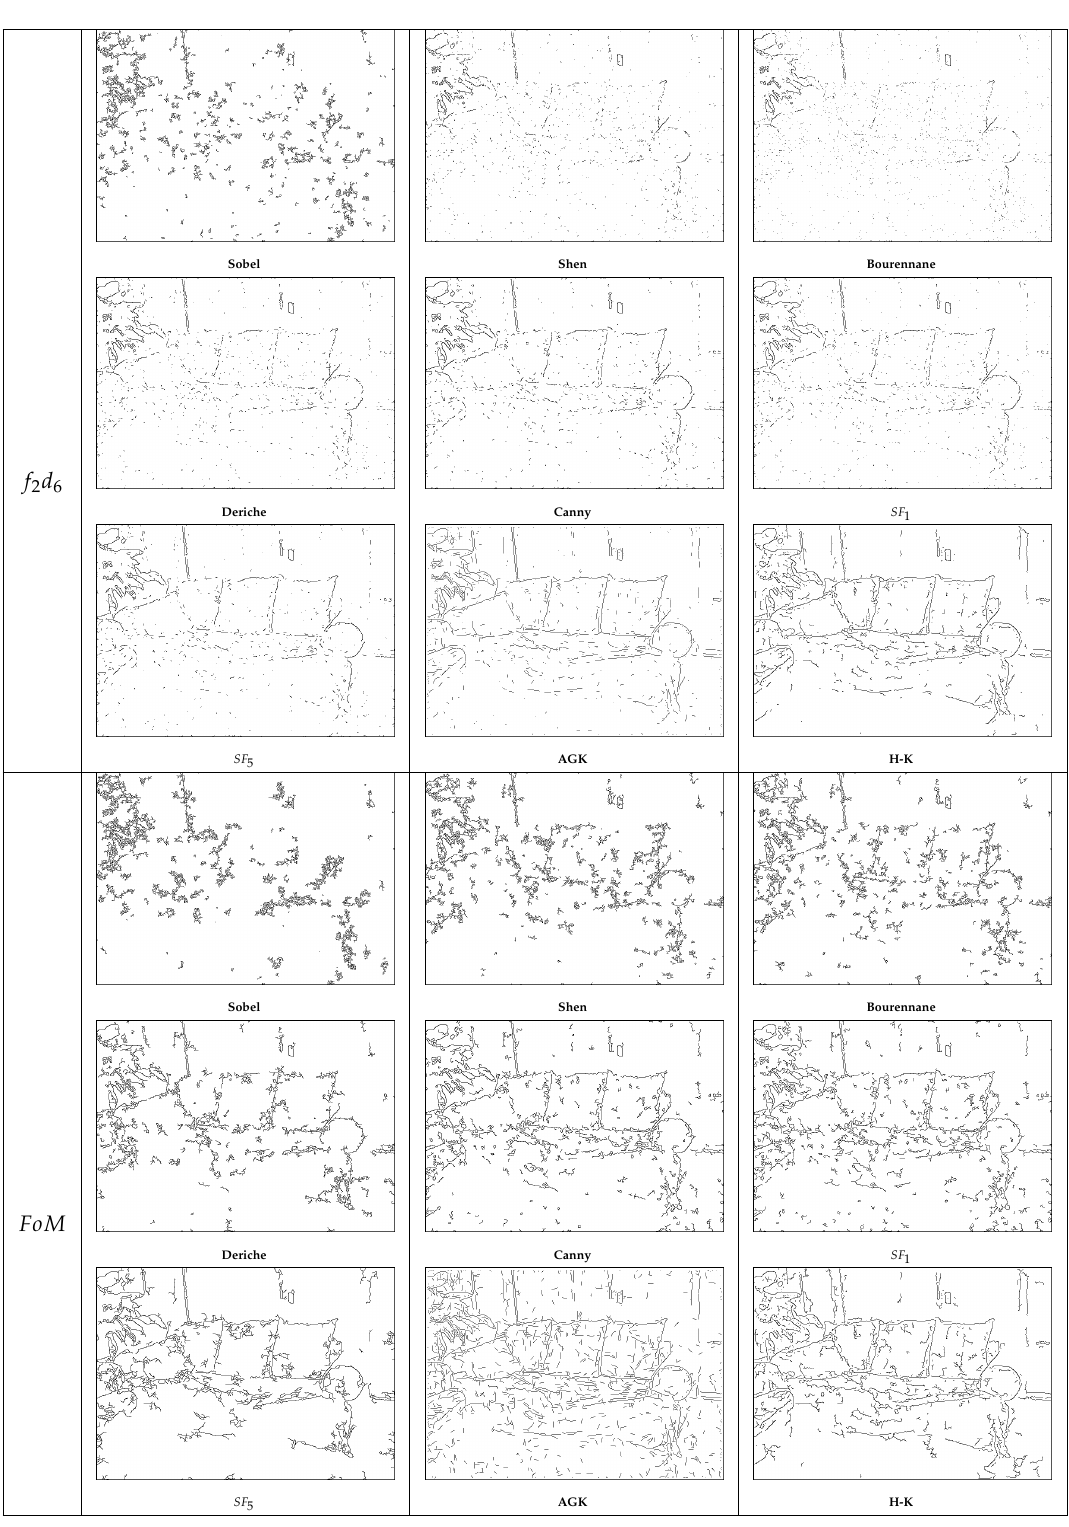
Figure 28. Ideal segmentations for several edge detectors on image 109, PSNR = 14